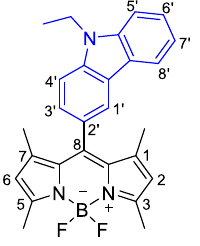
Figure 1. Structure of BODIPY derivative 1 .